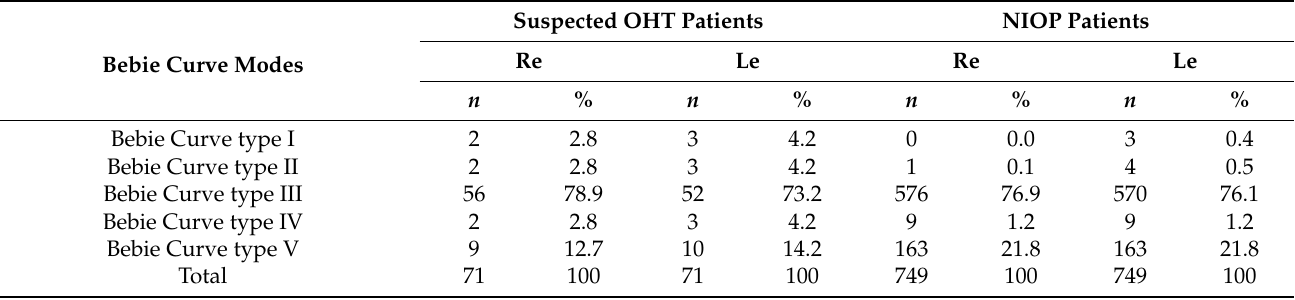
Table 6. Distribution of the types of “Bebie Curve” from the “Visual field” examination for suspected OHT and NIOP